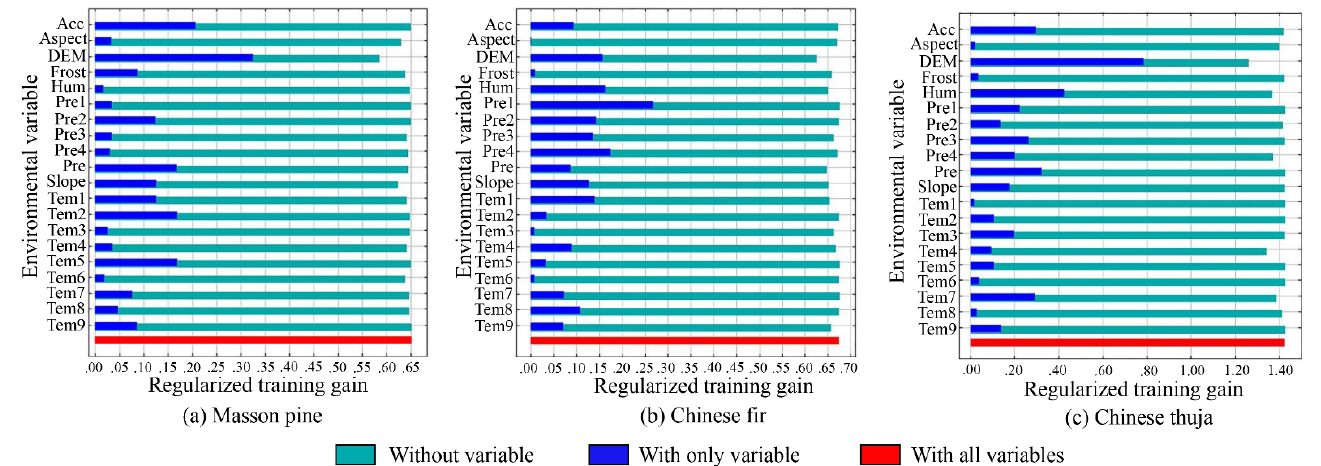
Figure 3. Jackknife environmental variable contribution. The vertical axis represents each geograph- ical factor, and the horizontal axis represents the training score value of each factor. Green, blue and red columns respectively represent the sum of fitting scores of all variables without fitting the variable and only fitting the factor. The high score of the blue column indicates that the variable has high prediction ability, and the low score of the green column indicates that the variable contains more special information.